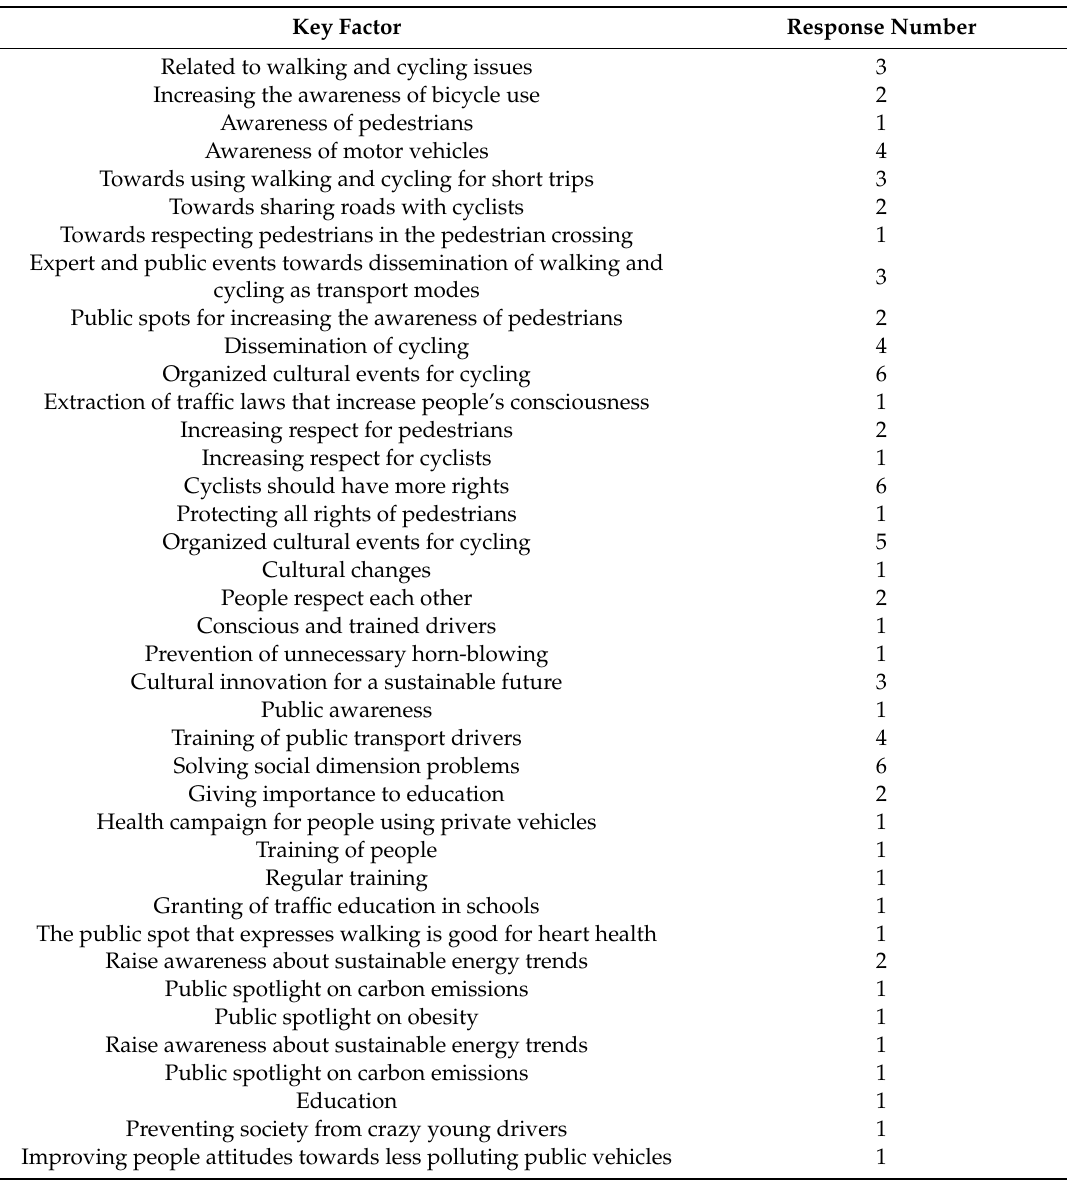
Table A8. Public